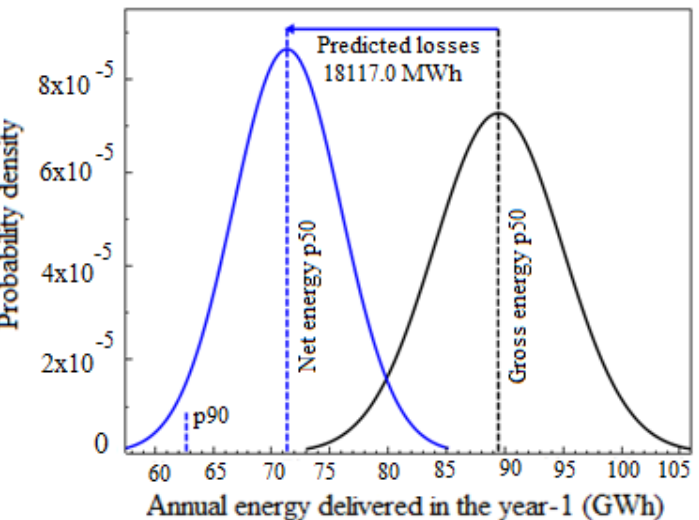
Figure 20. System’s predicted losses considering wake losses (layout 3).